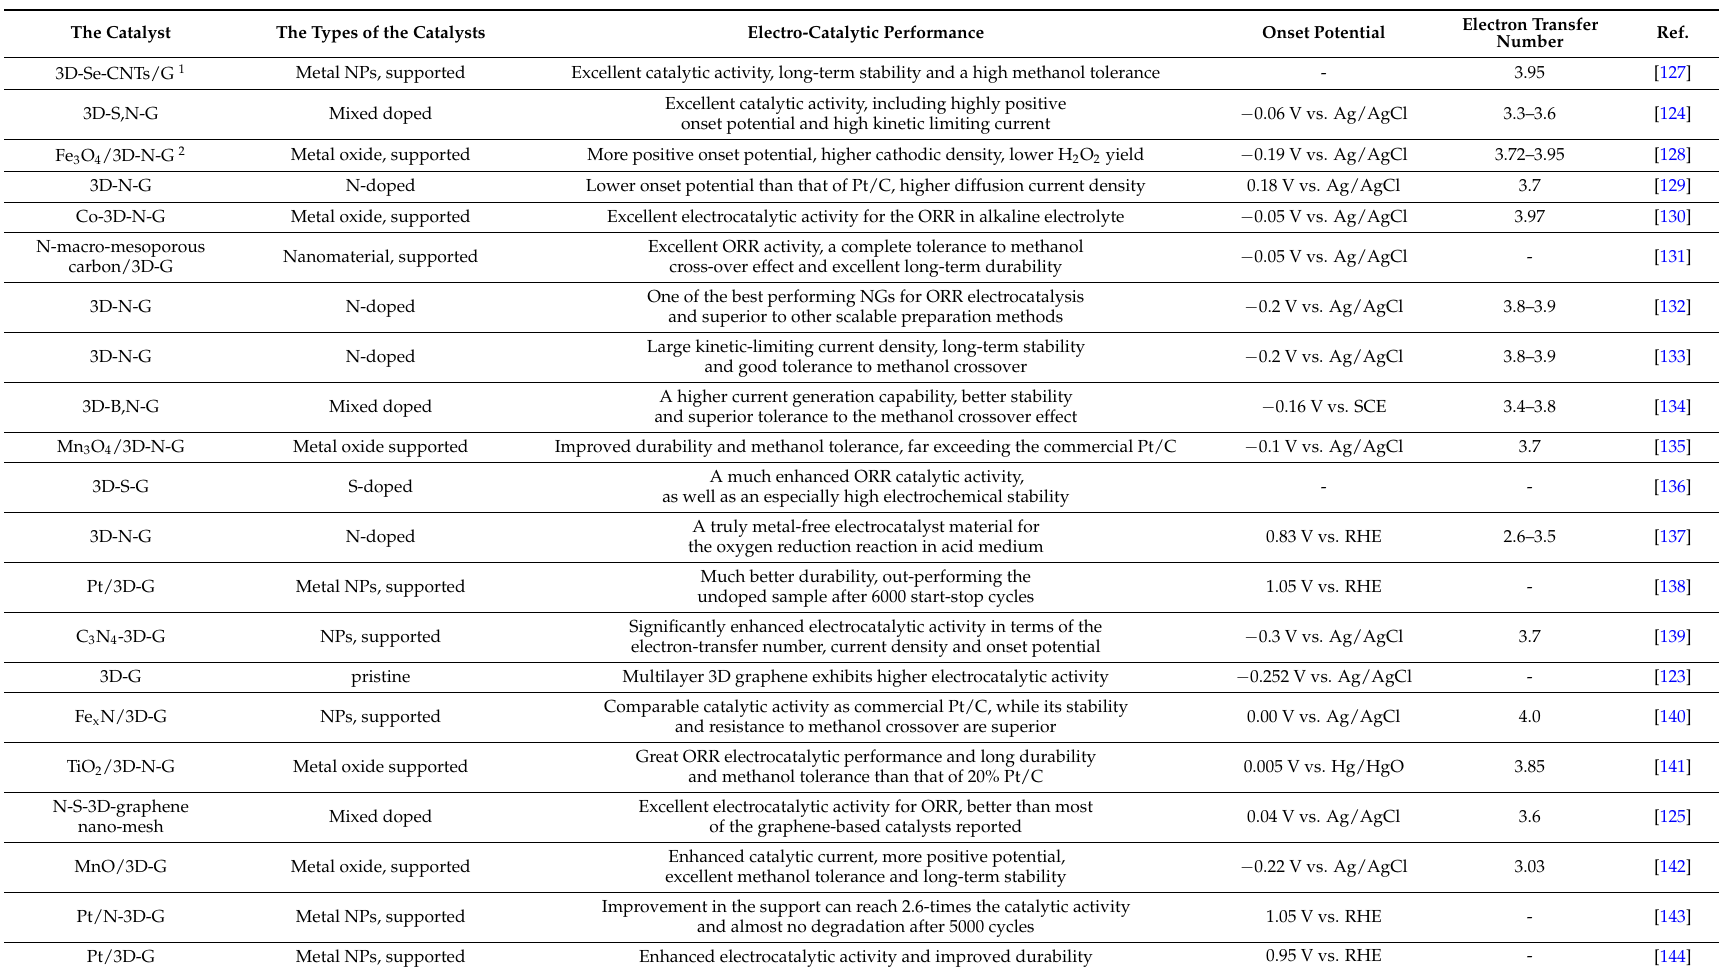
Table 1. Summary of some typical work of 3D-G-based material on